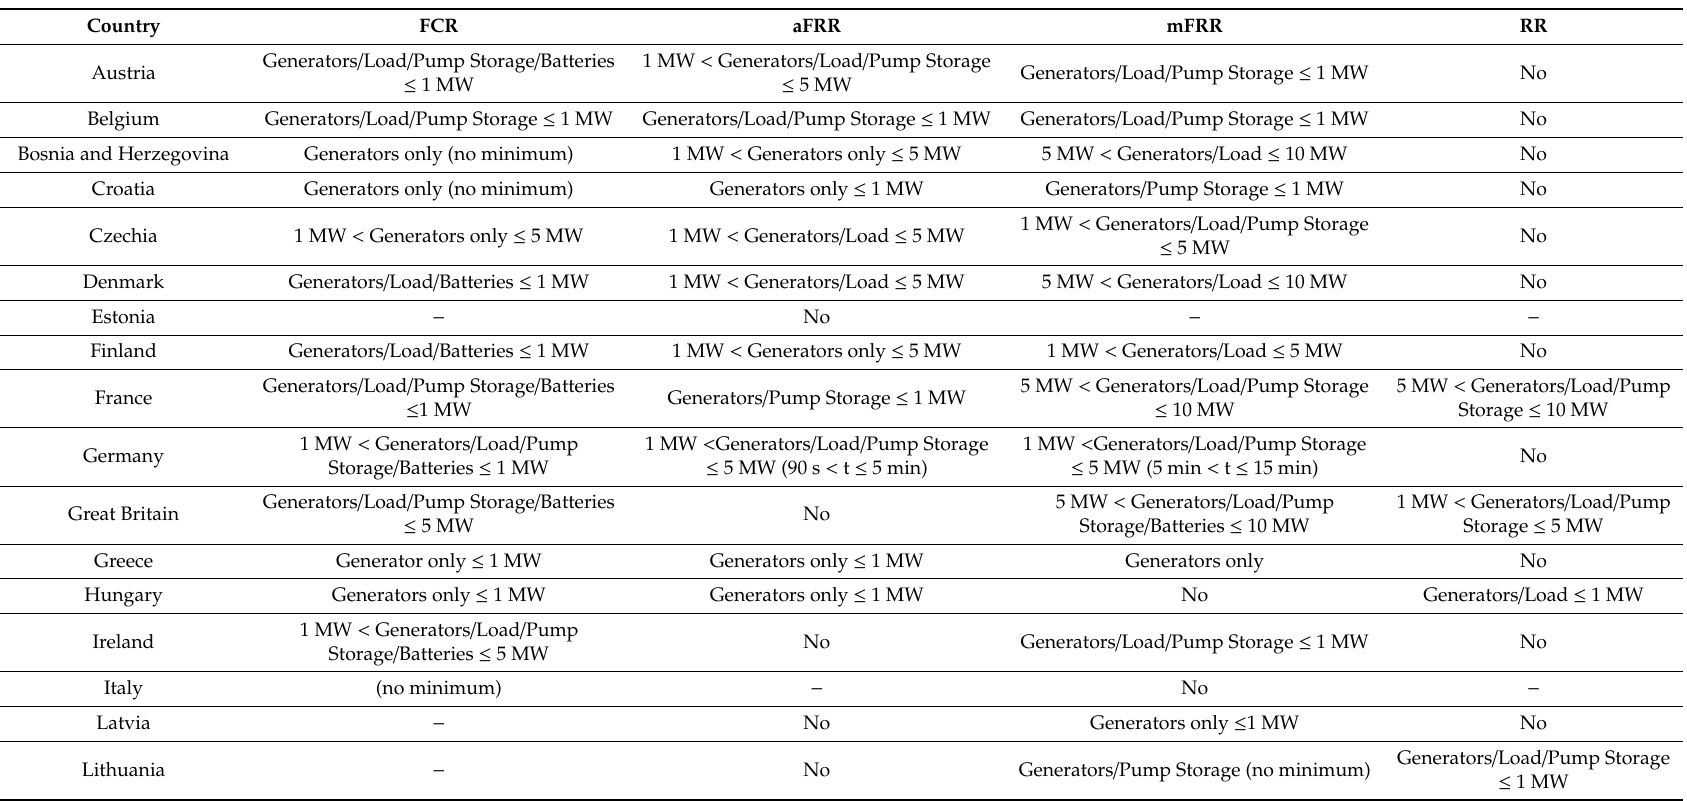
Table A1. Frequency reserves in various EU